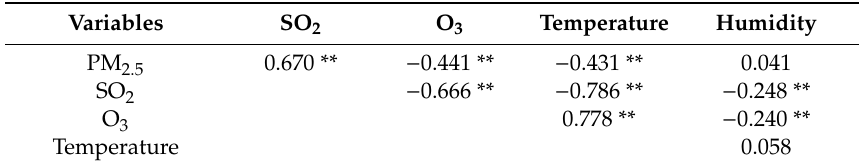
Table 2. Spearman’s correlation coefficients between daily ambient air pollutants and climatological factors in Xi’an from 2014–2016.